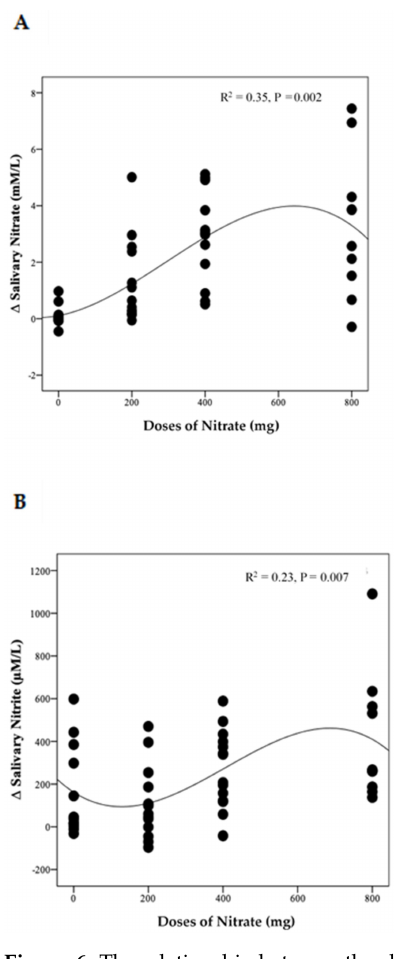
Figure 6. The relationship between the changes in salivary NO 3 − ( A ) and NO 2 − ( B ) and daily doses of NO 3 − delivered during the intervention. A cubic model was the best fit for each distribution ( n =